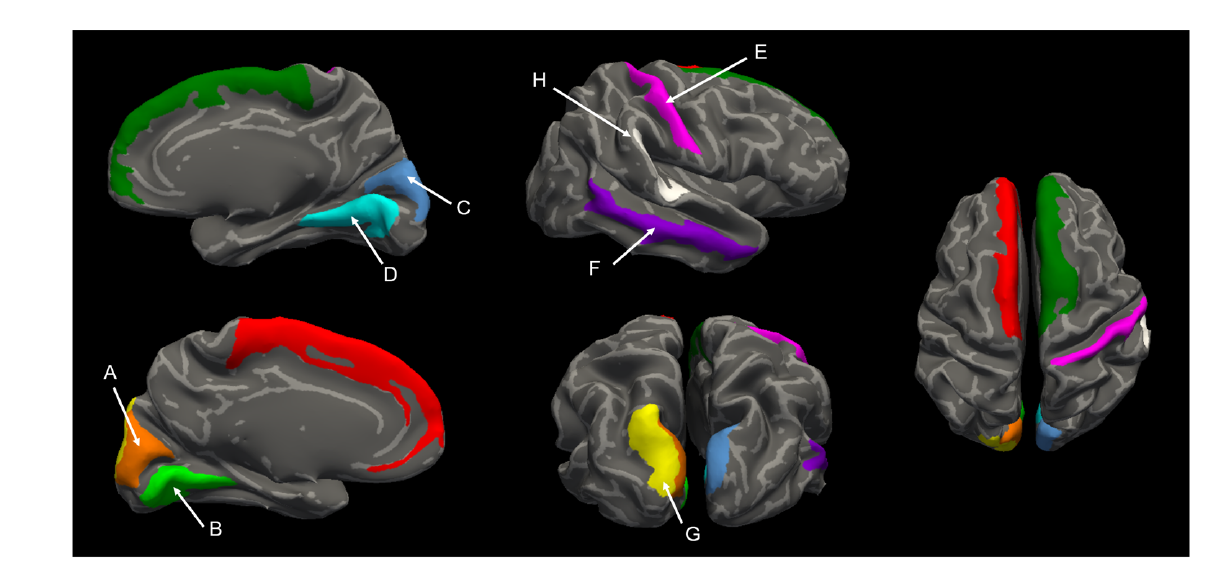
Figure 1. The lower panel shows scatter plots of the correlation analyses between cortical thickness and methylation scores of cg18793688 ( A – F ) and cg09418290 ( G – H ) in the MDD group on the corti- cal regions, which showed significant thickness differences between the MDD and HC groups (( A )—left cuneus; ( B )—left lingual gyrus; ( C )—right cuneus; ( D )—right lingual gyrus; ( E )—right postcentral gyrus; ( F )—right middle temporal gyrus; ( G )—left superior occipital gyrus; ( H )—right planum temporale). The upper panel shows schematic maps based on the Destrieux atlas regarding the cortical regions, with significant correlations between their thickness and the methylation scores of cg18793688 and cg09418290 in MDD group. The letters ( A – H ) represent the corresponding corti- cal regions in the scatter plots. 3. Discussion To our knowledge, this is the first study to investigate the association between DNA methylation levels of the NLRP3 gene and changes in cortical thickness in MDD patients. This study has three important findings. First, we identified several significant DMPs in NLRP3 in MDD patients compared to HCs. Second, we showed that MDD patients had significant correlations between the DNA methylation levels of NLRP3 and the cortical thickness of related regions, which were significantly altered in MDD patients compared to HCs. Our findings are based on a relatively medium-to-large sample size, along with conservative multiple-comparison correction and adjustment for potential confounders. Herein, we found five differentially methylated CpG sites in the NLRP3 gene, located in the gene body, TSS200, and 3 ′ UTR regions, in the comparison between the MDD and HC groups with a comprehensive investigation of 753,531 CpGs. NLRP3 is a major com- ponent of the NLRP3 inflammasome, which is an intracellular multiprotein complex com- posed of NLRP3 as a sensor, an apoptosis-associated speck-like protein containing a caspase activation and recruitment domain as an adaptor, and caspase-1 as an effector protein [20,21]. The NLRP3 inflammasome machinery plays an important role in innate